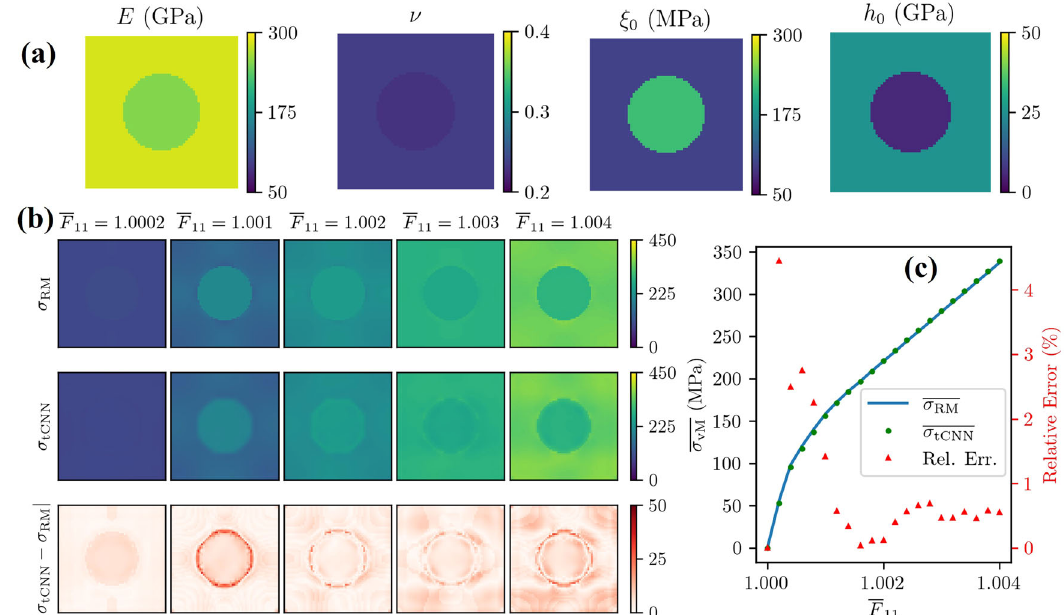
Fig. 6 Round inclusion test microstructure subject to uniaxial extension along the horizontal axis. a Young ’ s modulus E , Poisson ’ s ratio ν , initial fl ow resistance ξ 0 , linear isotropic hardening modulus h 0 . b Results for σ RM (above), σ tCNN (middle), ∣ σ tCNN − σ RM ∣ (below) (all MPa), at different F